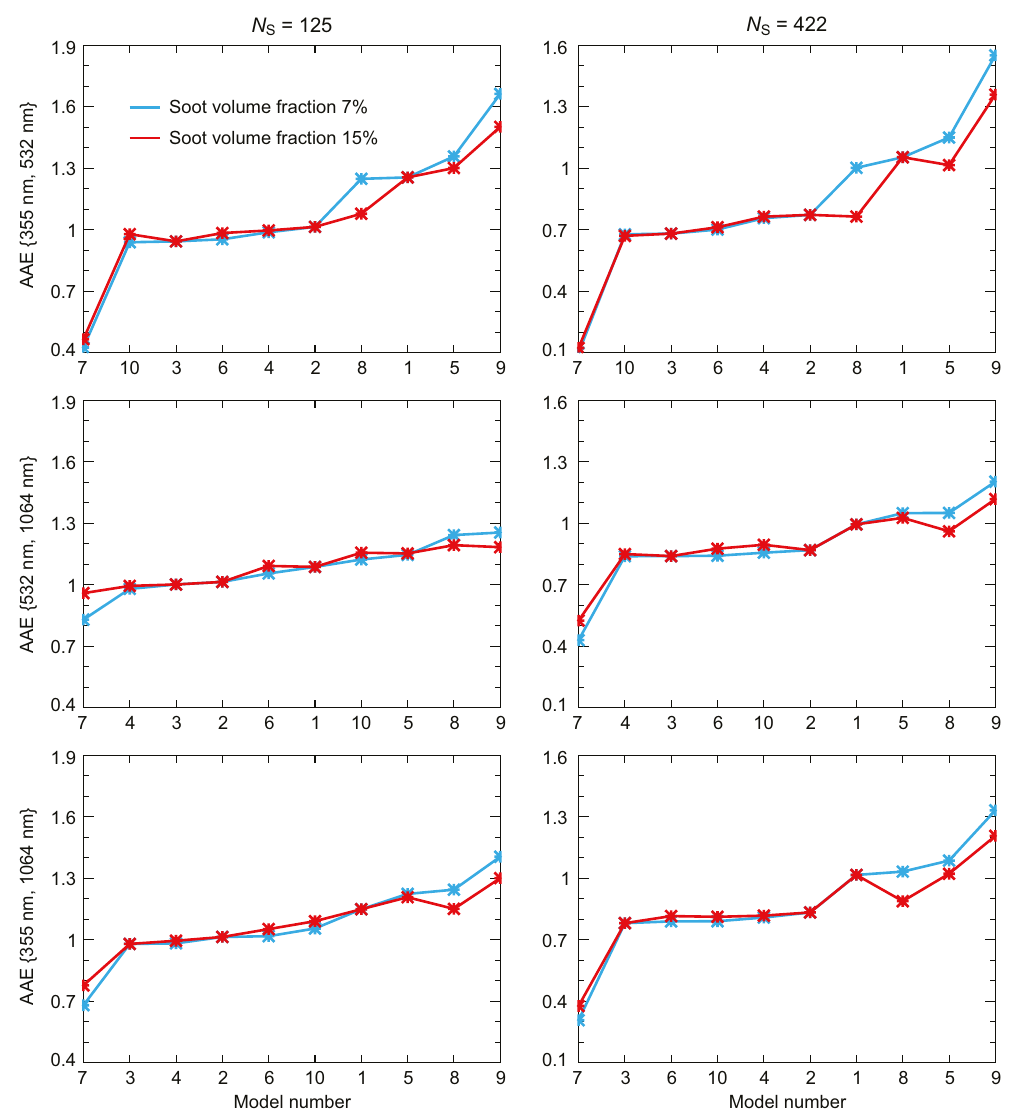
Figure 6. As in Figure 5, but for the absorption Ångström exponent (AAE). The number of soot spherules is N S = 125 (left-hand panels) and 422 (right-hand panels).